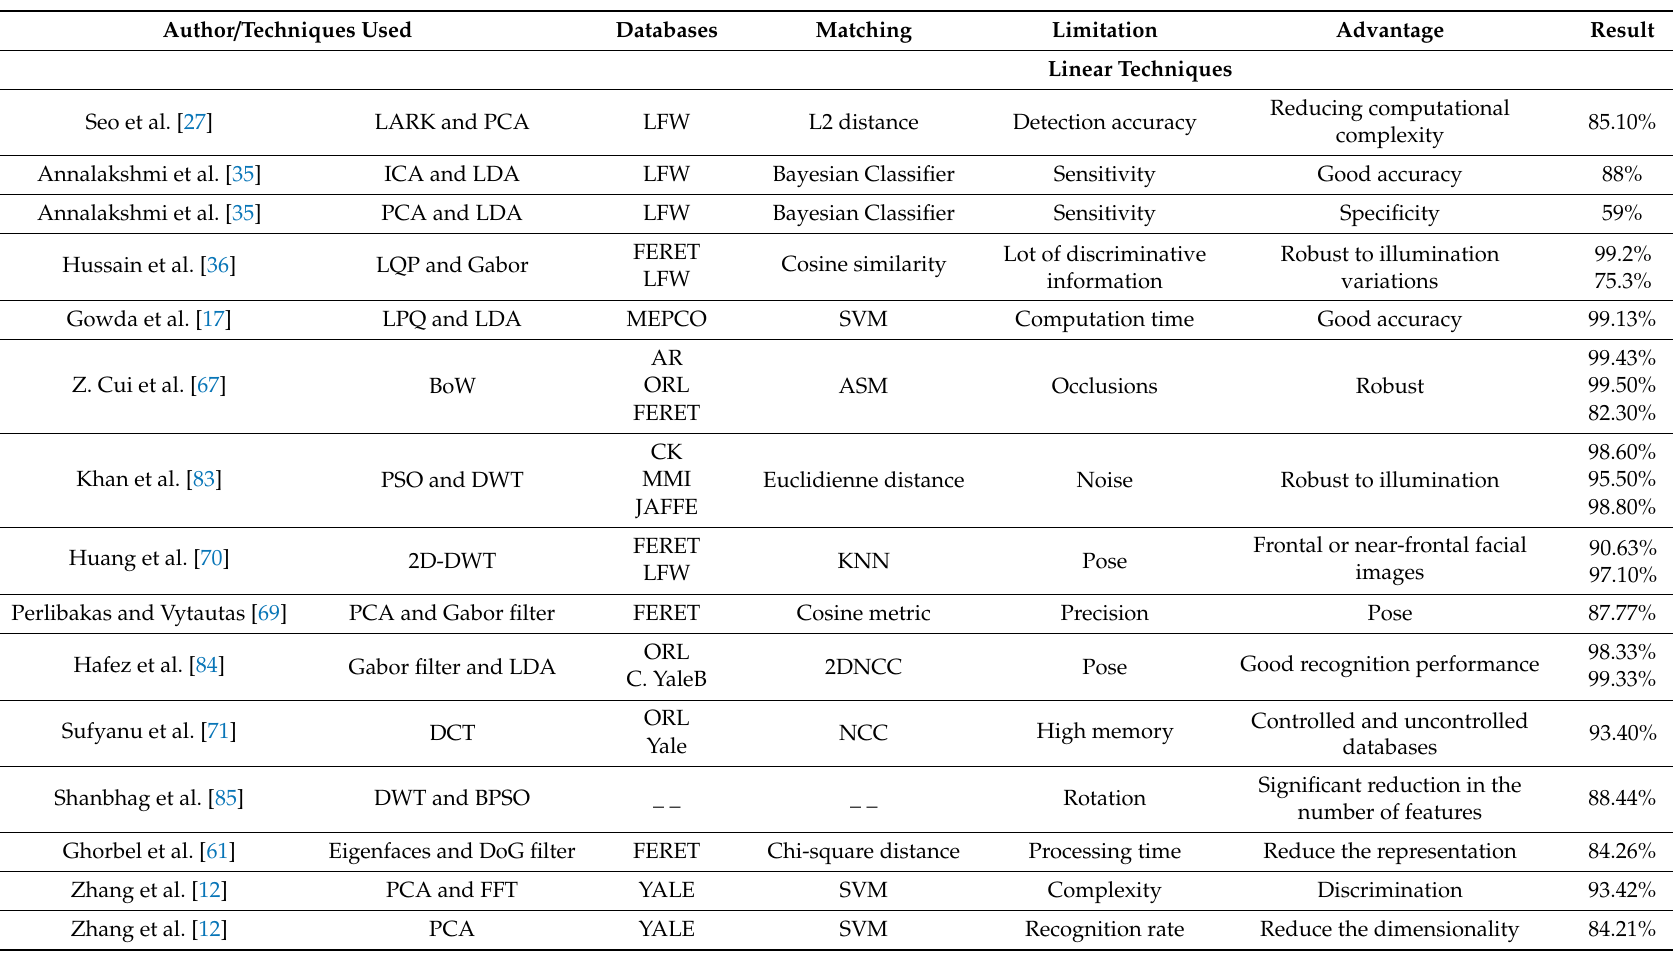
Table 2. Subspace approaches. ICA, independent component analysis; DWT, discrete wavelet transform; FFT, fast Fourier transform; DCT, discrete cosine